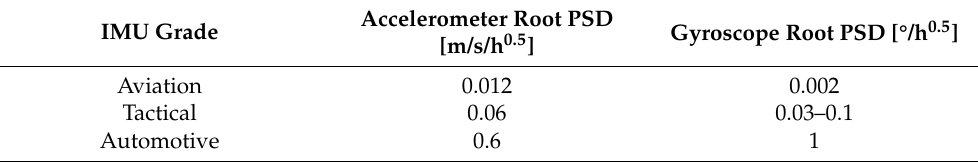
Table 3. Typical inertial sensor system noise according to IMU